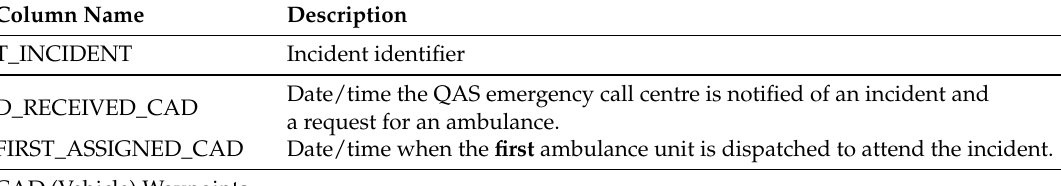
Table 1. QAS - Data attributes and descriptions.